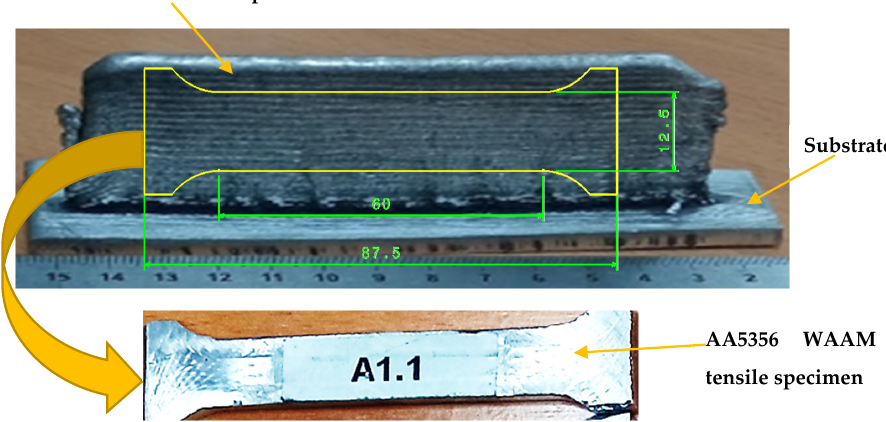
Figure 3. Tensile specimen layout according EN ISO 6892-1:2016.